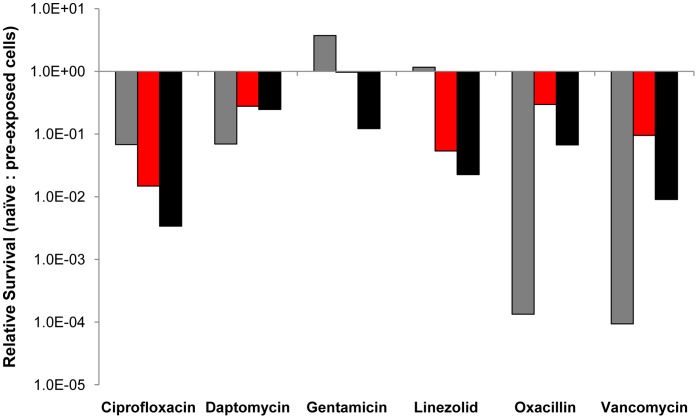
Relative survival of unexposed (naïve) to previously antibiotic-exposed (sophisticated) S. aureus PS80 after three hours of exposure in antibiotic-containing filtrates from the treated continuous culture (Figure 2).The sophisticated bacteria and filtrates used for these experiments were taken at 3 hours (gray), 51 hours (red), and 123 hours (black). The biologically active concentrations of antibiotics are reported in Table S1. Data summarized from Figure S1.